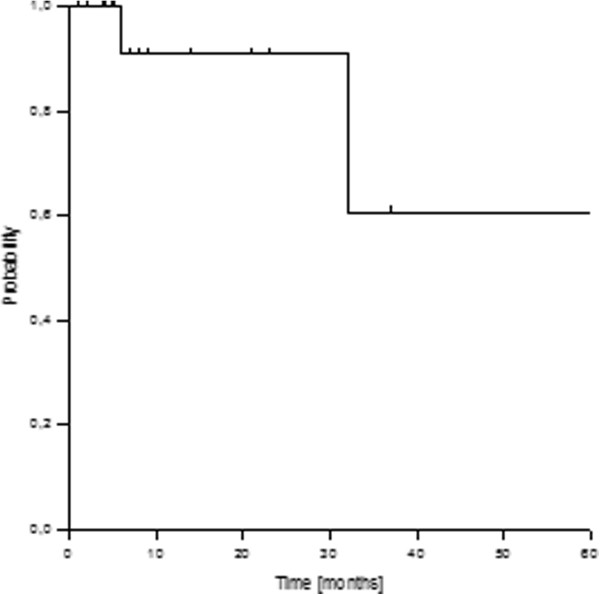
Actuarial local control rate.